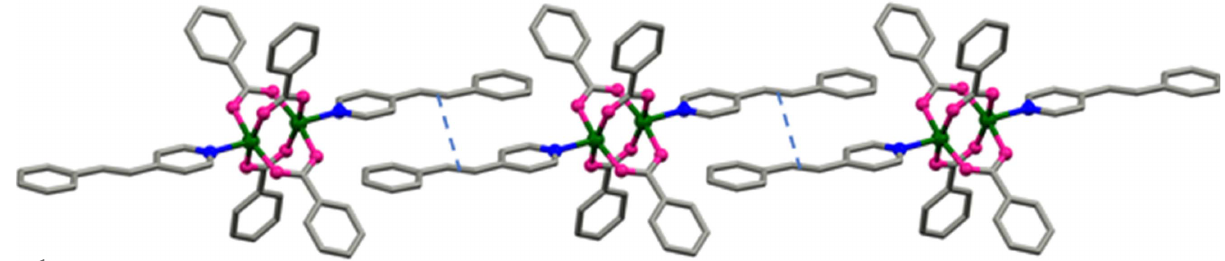
Figure 1 View of the one-dimensional arrangement of [Cu 2 (benzoate) 4 (4-spy) 2 ] 1 via (cid:2) – (cid:2) interactions. Hydrogen atoms have been omitted for